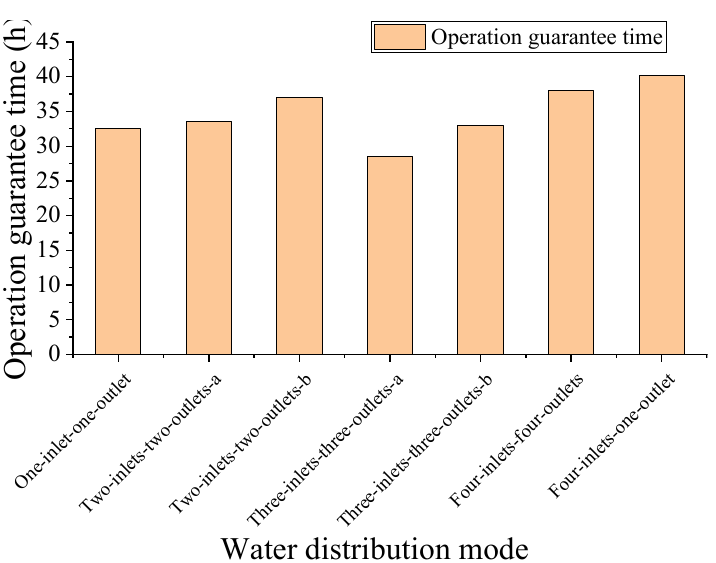
Figure 21 shows the influence of the simulated water distribution modes on a reservoir guaranteed operation time. According to the simulation results, the order of the guaranteed operation times from longest to shortest is four-inlets–one-outlet; four-inlets–four-outlets; two-inlets–two-outlets-b; two-inlets–two-outlets-a; three-inlets–three-outlets-b; one-inlet– one-outlet; and three-inlets–three-outlets-a.